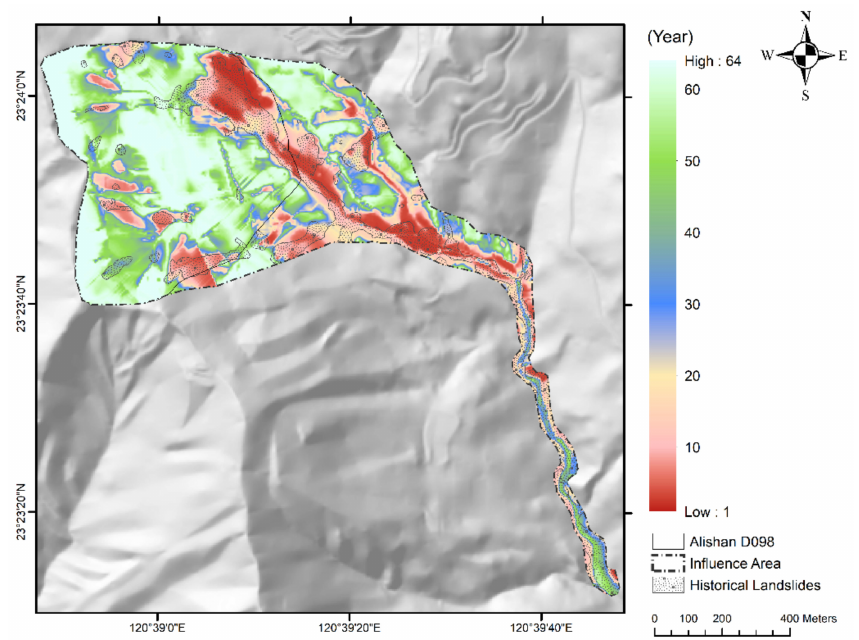
Figure 13. The distribution of recurrence interval of revised landslide rainfall threshold in the influence